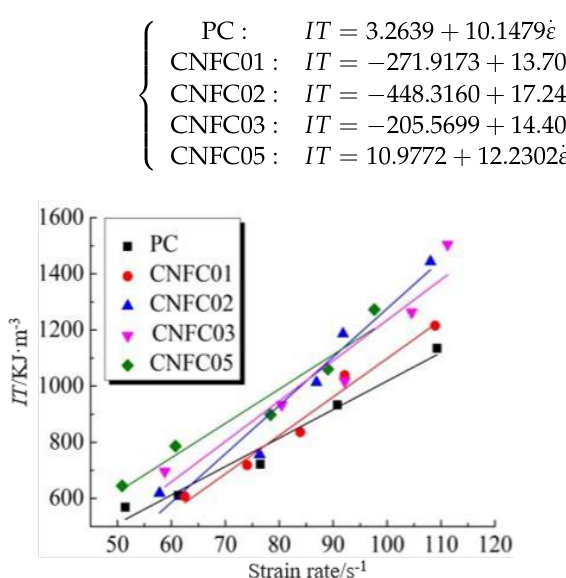
Figure 8. Impact toughness of concrete under different strain rates.